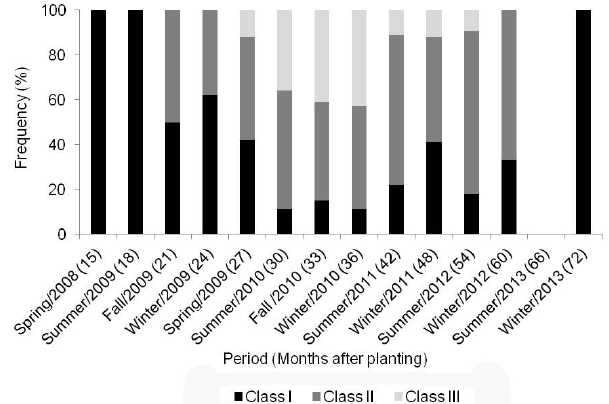
Fig 2. Frequency of Acromyrmex crassispinus nests in a Pinus taeda planting, by size class: Class I, up to 30 cm in diameter, Class II, between 31 and 60 cm; and Class III, greater than 61 cm. São Mateus do Sul, PR, Brazil, 2008-2013. Table 1. Chi-square test of adherence of observed frequencies to the expected Poisson distributions, positive and negative binomial distribu - tions for Acromyrmex crassispinus nests in a Pinus taeda